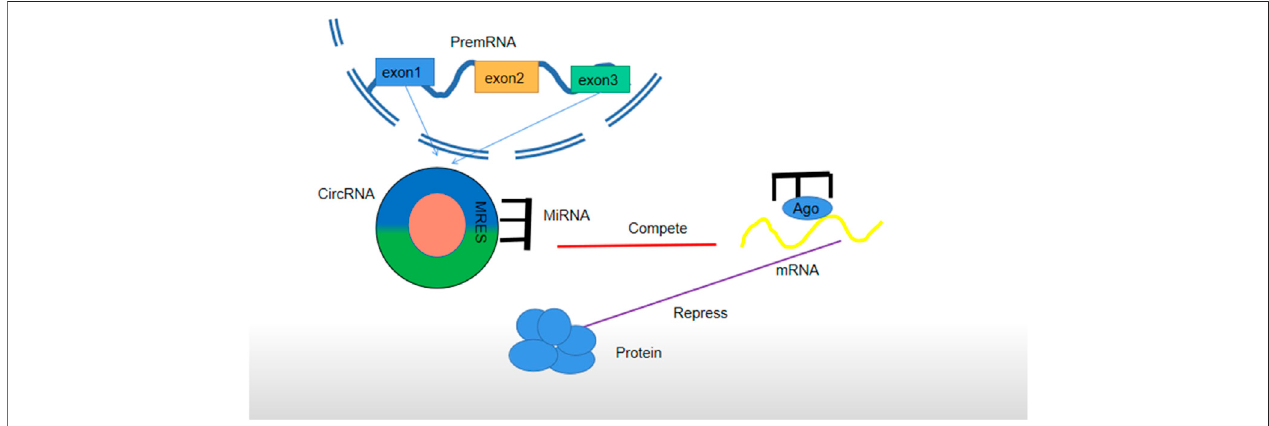
FIGURE3| Regulatorymechanism ofcircRNA asceRNA. CircRNAiscutoff from aprecursor RNAtosponge miRNA,block the expression ofanmiRNA-targeted gene (mRNA) in cells, and form a circRNA – miRNA – mRNA network. It has the same role in exosomes secreted by cells. Each miRNA can form a silent complex with an Argonaute (AGO) protein. An miRNA pairs with a target transcript, and the AGO protein promotes either target instability or transcriptional suppression.